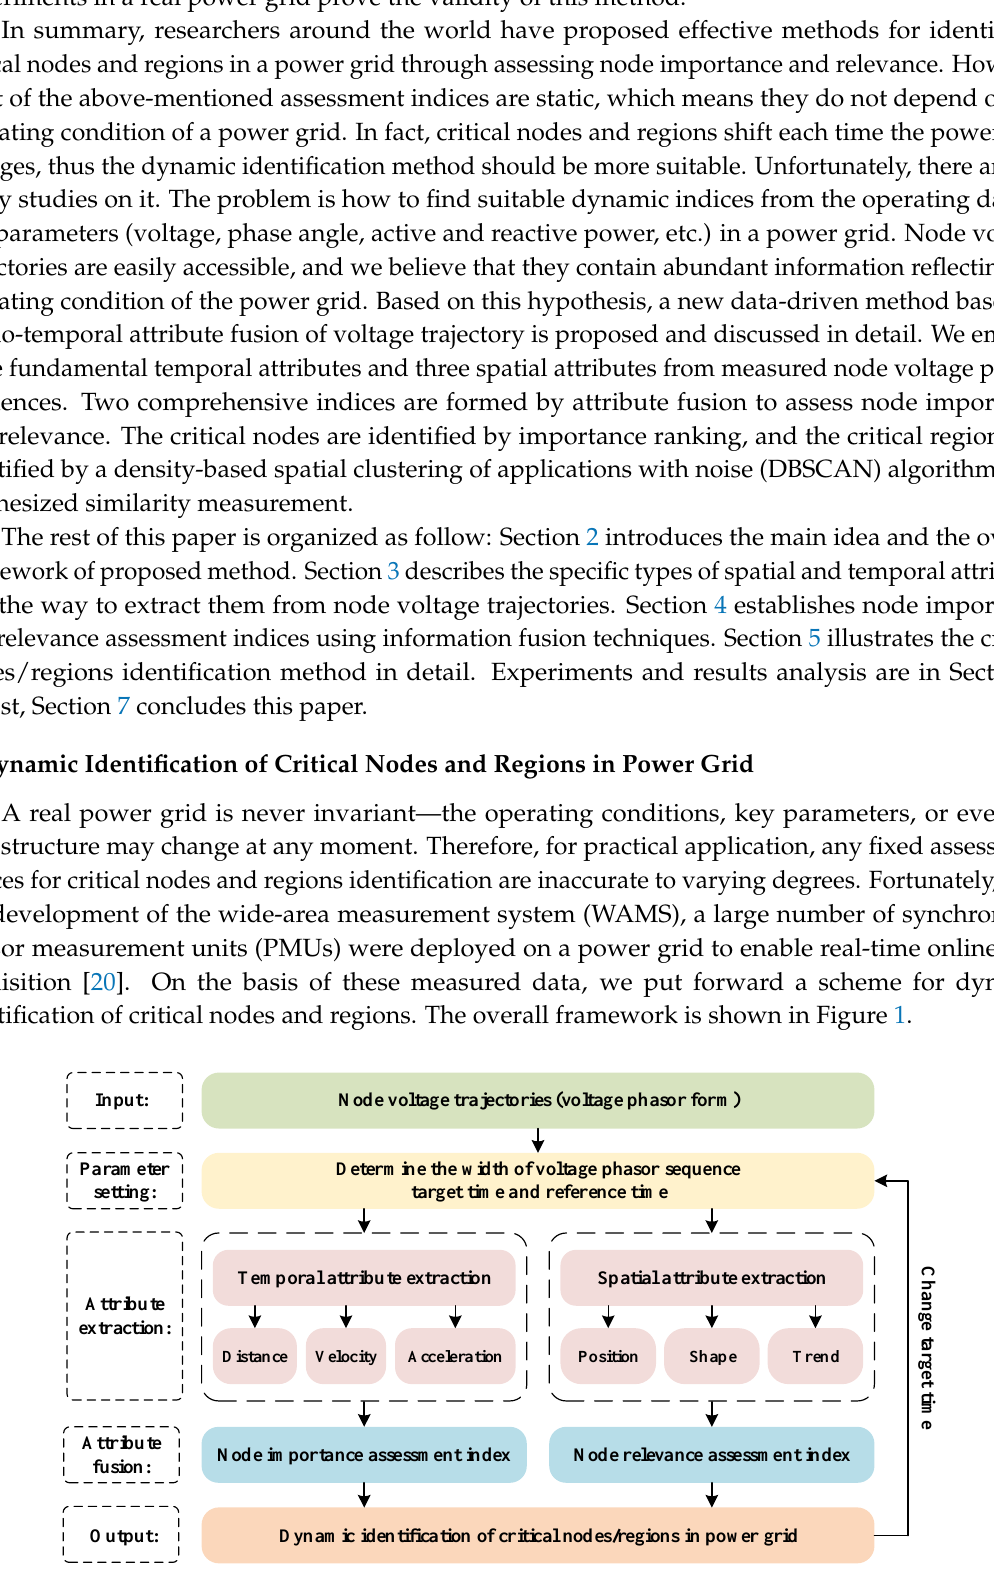
Figure 1. Overall framework of proposed scheme.